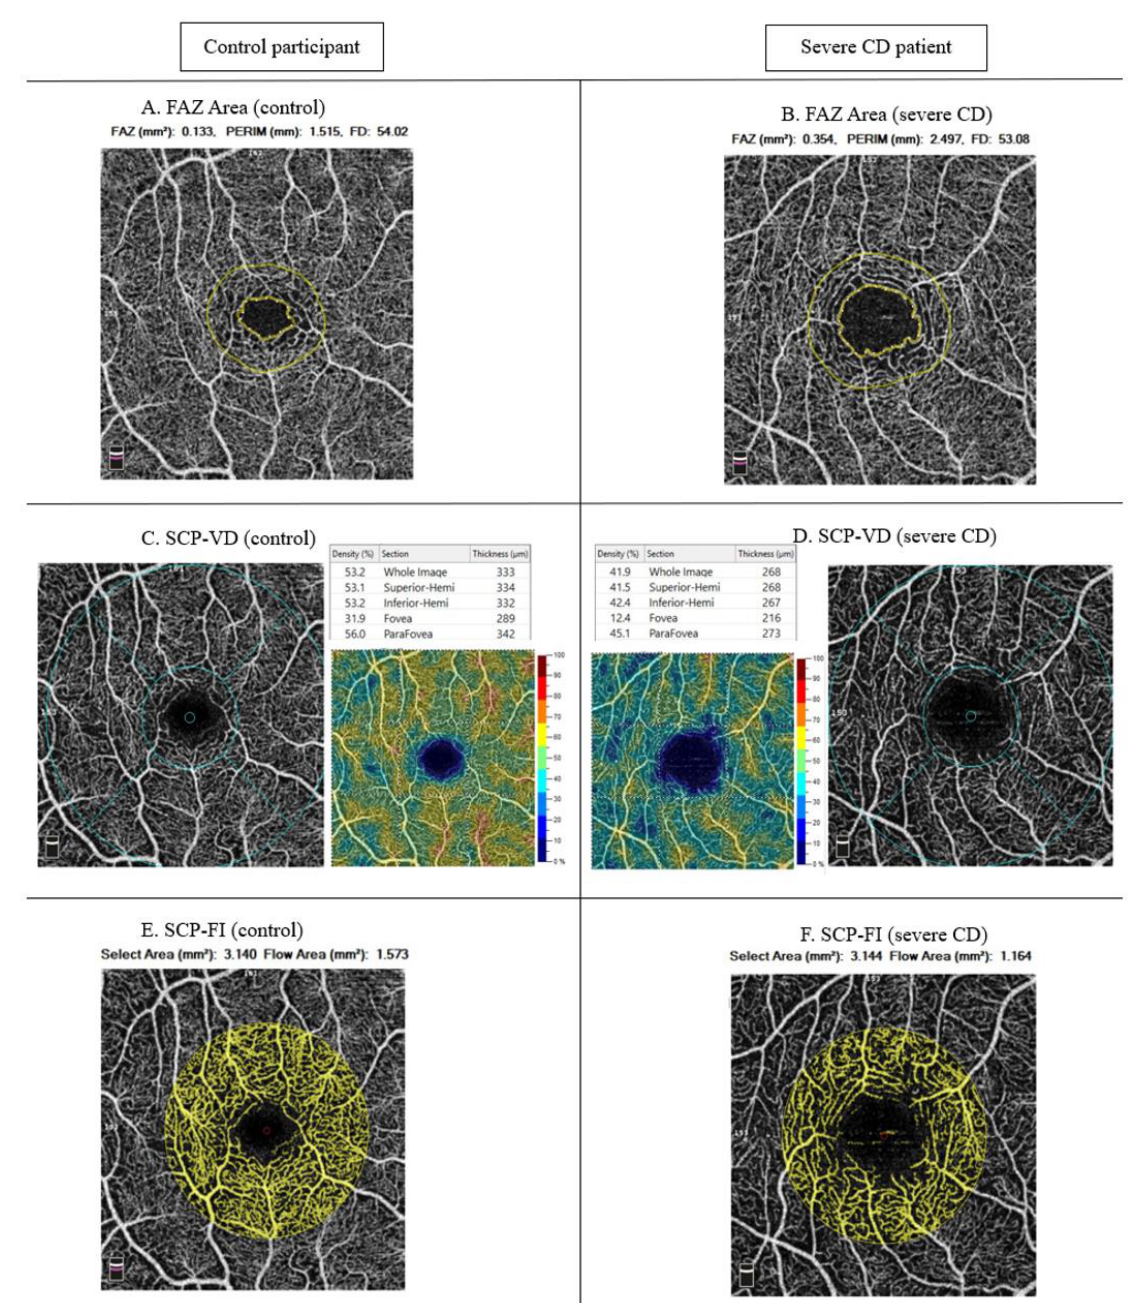
Figure 1. Examples of OCT-A images for controls and patients with severe CD. Abbreviations: CD — Crohn’s disease; FAZ— foveal avascular zone; FI — flow index; SCP — superficial capillary plexus; VD — vascular density. Perfusion vascular density (VD) and foveal avascular zone (FAZ) were automatically